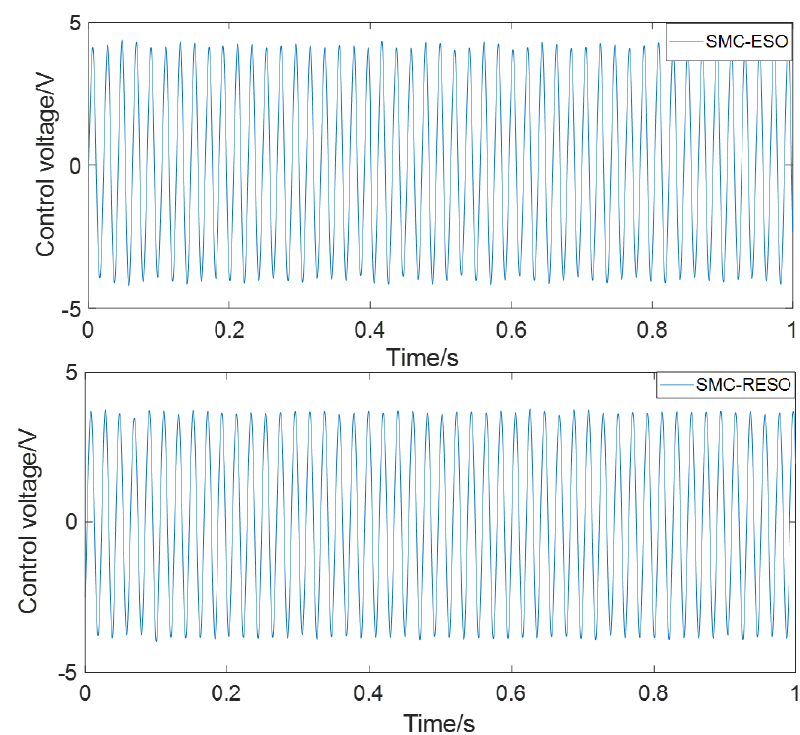
Figure 6. The FFT results of vibration amplitude: ( a ) frequency-response curve and ( b ) local frequency-response curve.